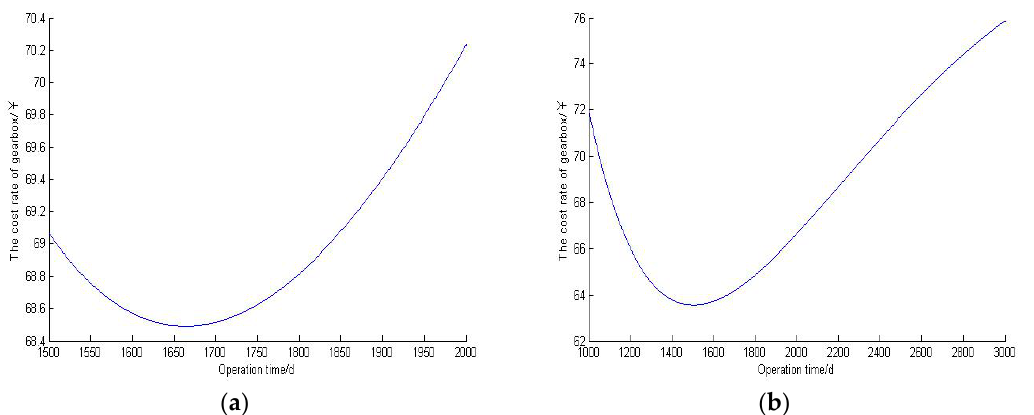
Figure 5. The cost rate of gearbox maintenance based on two- and three-parameter Weibull: the left-hand side ( a ) shows the gearbox maintenance cost rate of the two-parameter Weibull, and the right-hand side ( b ) shows the three-parameter Weibull.